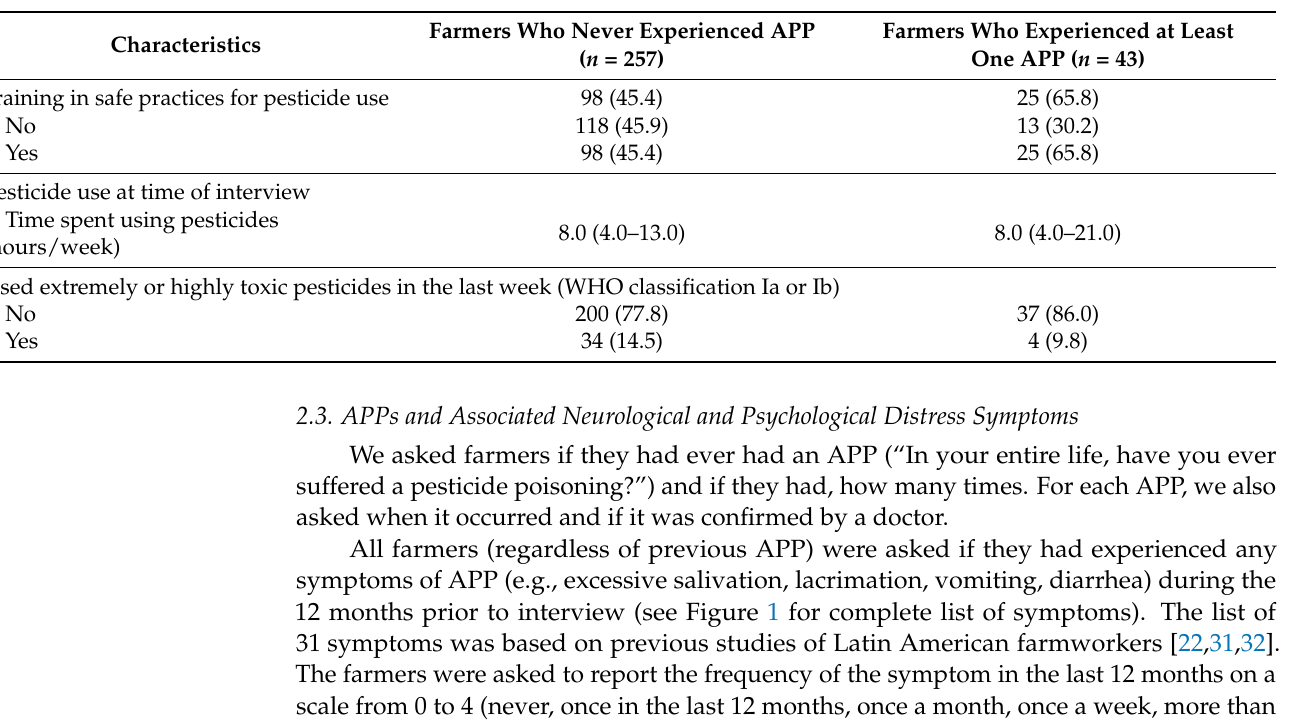
difference (MD): 0.93, 95% CI: 0.19, 1.66), insomnia (MD: 0.63, 95% CI: − 0.10, 1.37), dizzi- ness (MD: 0.61, 95% CI: − 0.12, 1.35), more irritable or angry than normal (MD: 0.61, 95% CI: − 0.12, 1.35), tired or low energy (MD: 0.54, 95% CI: − 0.19, 1.28), shaking hands (MD: 0.52, 95% CI: − 0.21, 1.25), Table A1). The only symptom that remained significant after adjustment for multiple testing was numbness or tingling in hands and feet. After adjusting for age, having experienced at least one APP was associated with in- creased odds of fainting (OR: 7.48, 95% CI: 1.83, 30.74), shaking hands (OR: 3.50, 95% CI: 1.60, 7.60), numbness or tingling in hands or feet (OR: 3.23, 95% CI: 1.66, 6.32), insomnia (OR: 2.53, 95% CI: 1.34, 4.79), accelerated heart rate (OR: 2.42, 95% CI: 1.03, 5.47), dizziness (OR: 2.38, 95% CI: 1.19, 4.72), being more irritable or angry than normal (OR: 2.37, 95% CI: